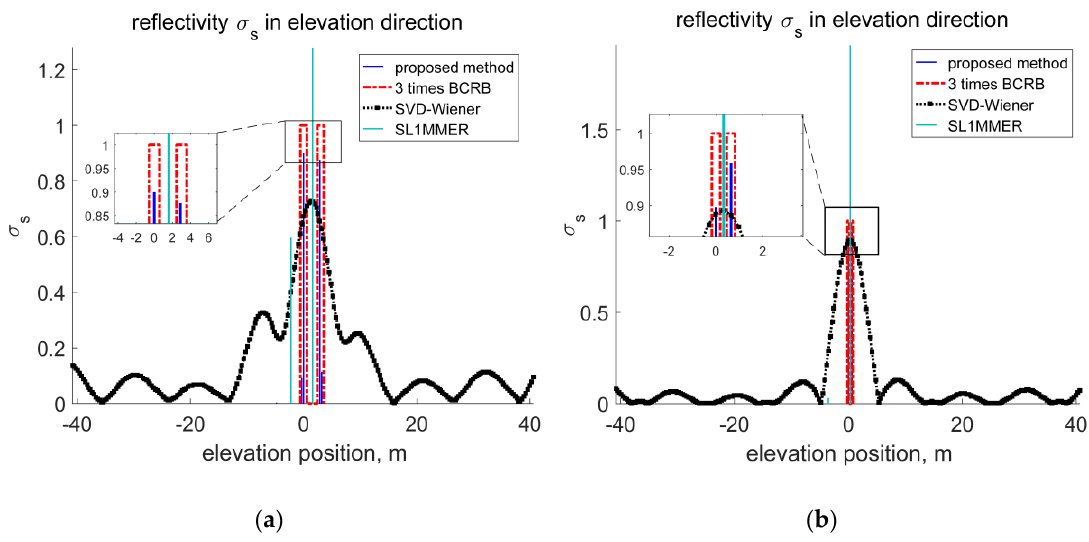
Figure 7. Comparison of reconstructed reflectivity profiles in elevation direction between proposed method and SVD-Wiener. ( a ) Scatterers’ distance 3 m, SNR = 10 dB, BCRB = 0.1875 m; ( b ) Scatterers’ distance 0.63 m, SNR = 20 dB, BCRB = 0.0593 m.